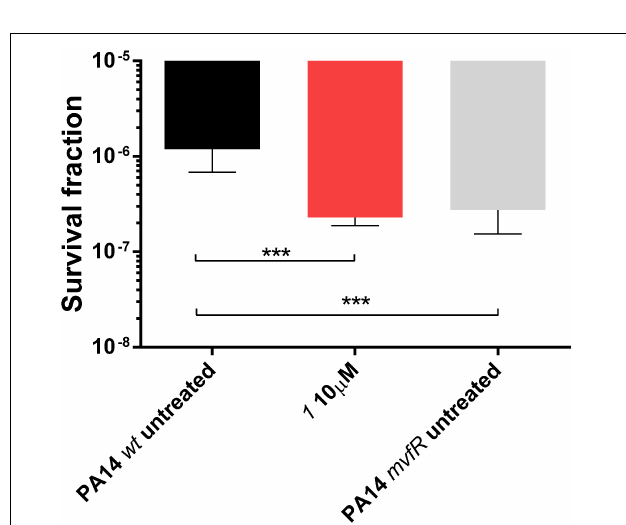
FIGURE 6 | Persister cells survival of PA14 wt with and without MvfR antagonist 1 and PA14 mvfR mutant after the treatment with 10 µ g/mL of meropenem for 24 h. The error bars indicate 95% Confidence Interval of the geometric mean. Statistical analysis performed with non-parametric one-way ANOVA ( α = 0.05; ∗∗∗∗ p < 0.0001; ∗∗∗ p < 0.003; ∗ p <